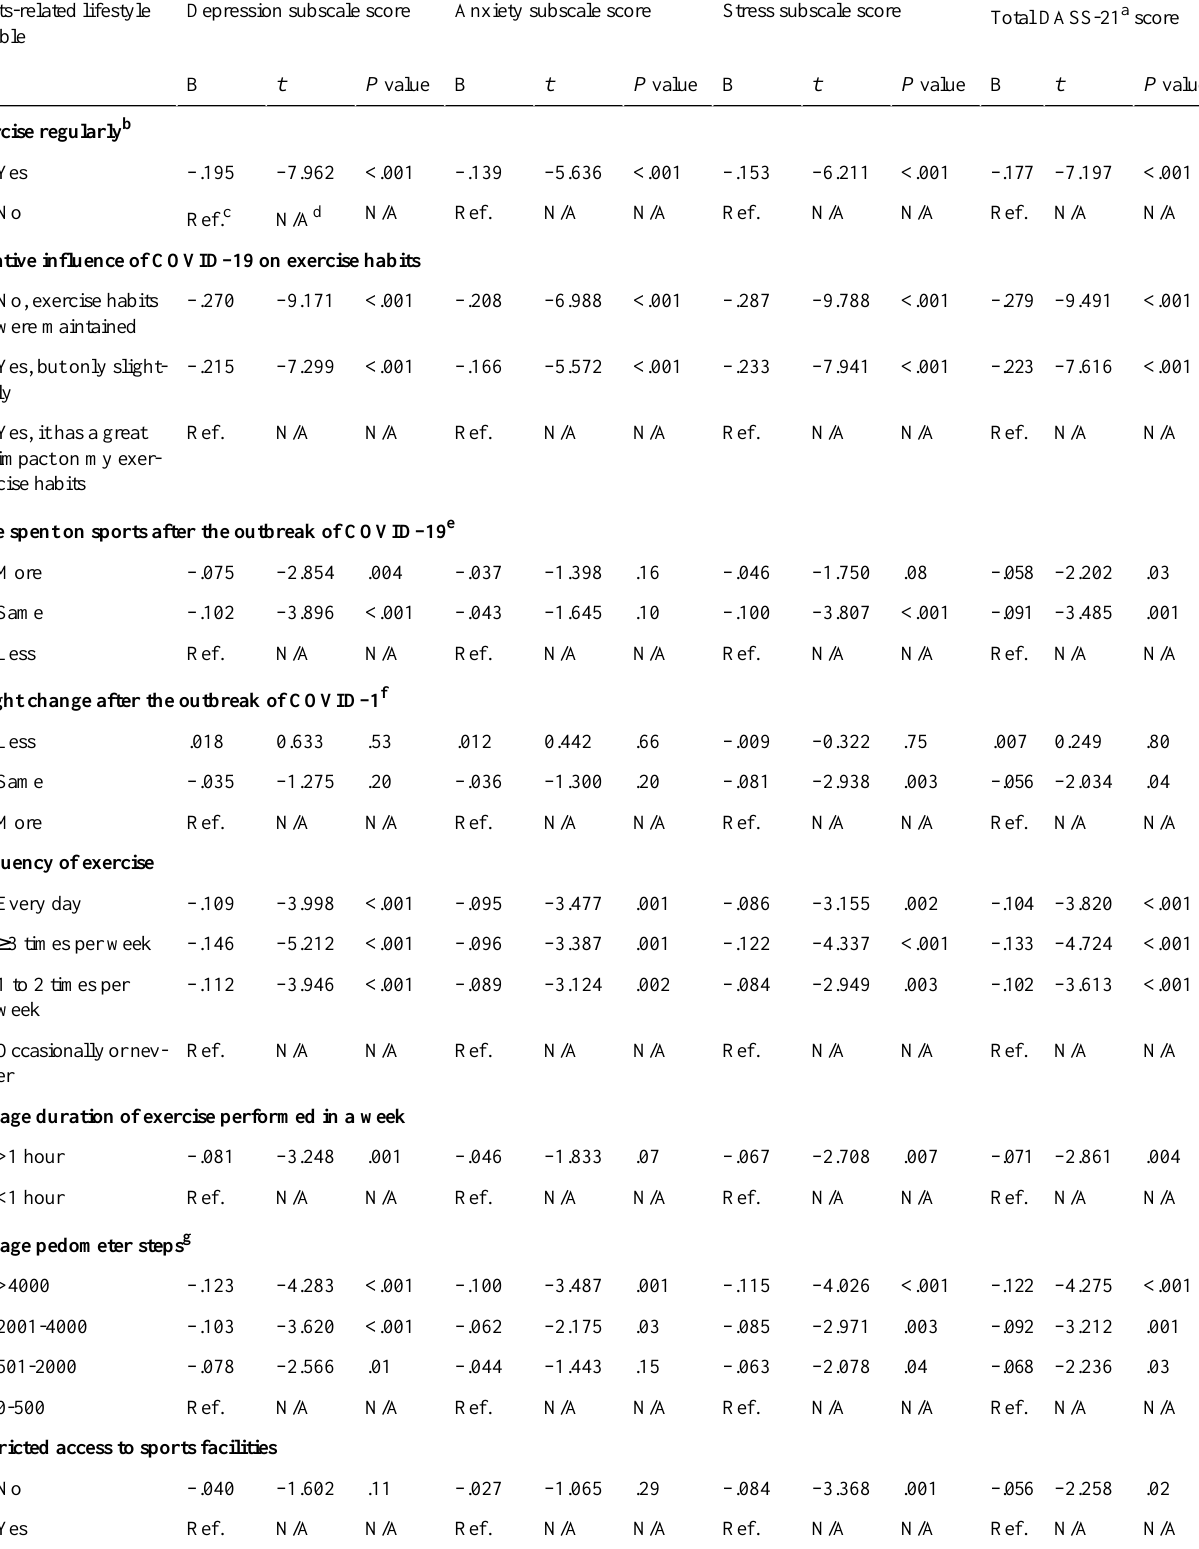
Total DASS-21 a scoreStress subscale scoreAnxiety subscale scoreDepression subscale scoreSports-related lifestyle